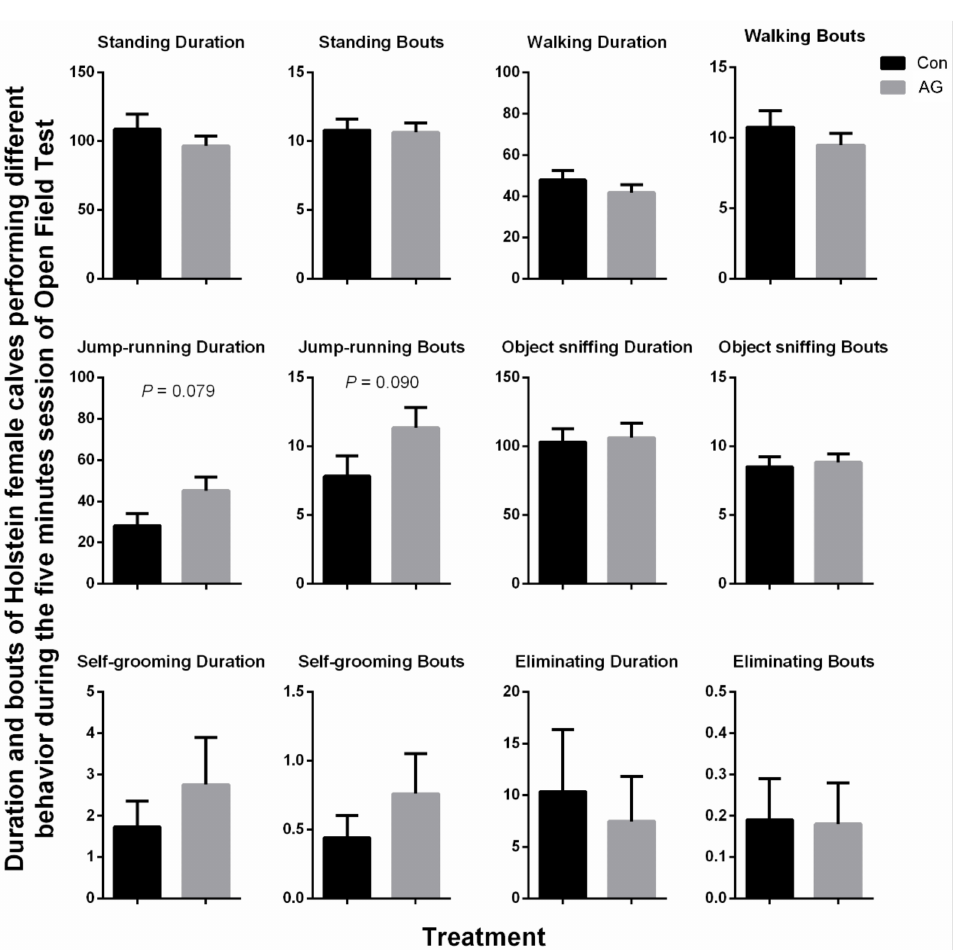
Figure 1. The e ff ect of artificial grooming on the behavior of Holstein female calves in the open field test on day 7 (s). E ff ect direction is provided when the mean e ff ect is p ≤ 0.10. Data are presented as means with standard error bars of SEM. Control group (Con), n = 16; Artificial grooming group (AG), n =